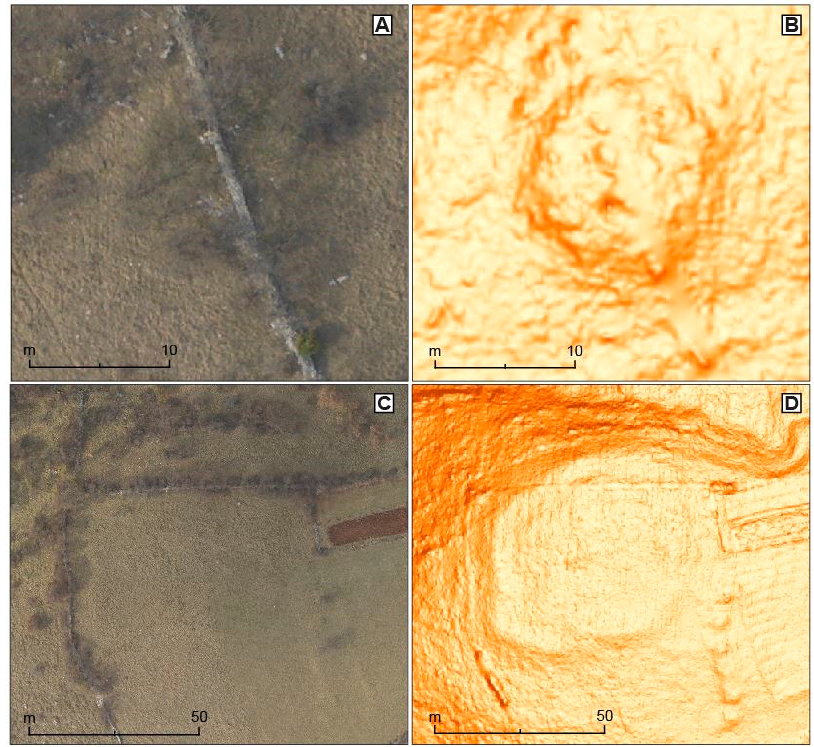
Figure 3. Ortophoto ( A ) and slope visualization ( B ) of feature 8; Ortophoto ( C ) and slope visualization ( D ) of feature 10.